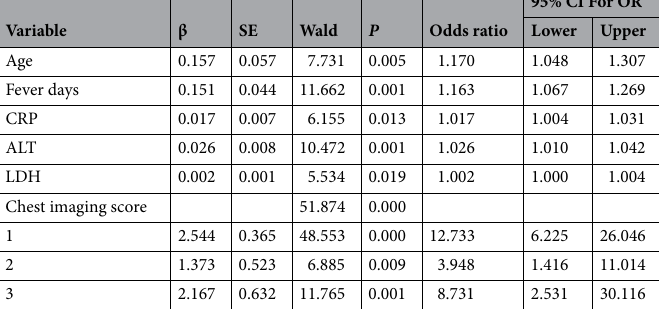
Table 4. Logistic regression analysis predictors of M. pneumoniae pneumonia. ALT alanine aminotransferase, CRP C-reactive protein, LDH lactate